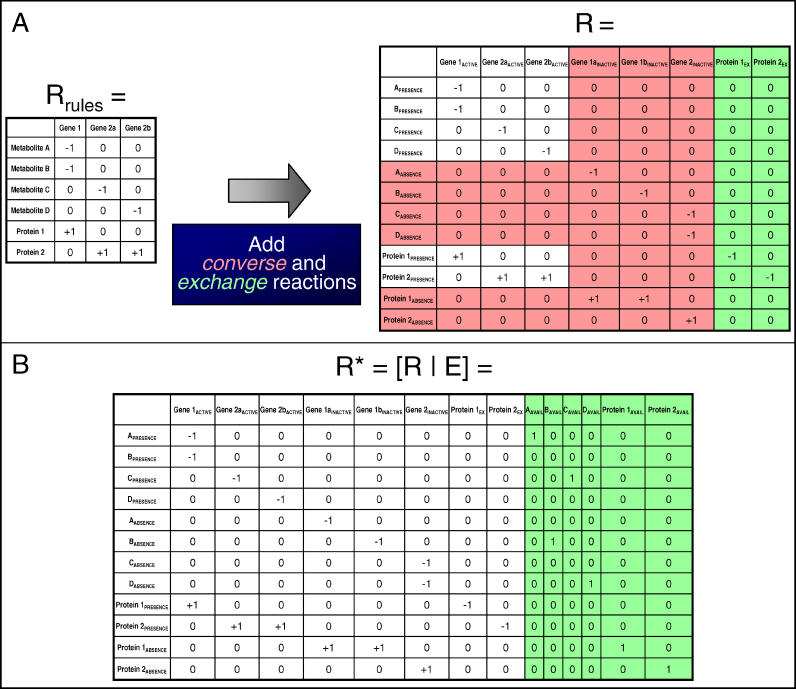
The Matrix as a Representation of a TRS(A) Depicts the TRN matrix shown in Figure 1 (Rrules). This matrix is expanded to yield the matrix R, which describes the complete TRS. The R matrix includes the converse of the regulatory rules, i.e., the regulatory reactions that lead to the inhibition of gene transcription (rows and columns shaded in pink). For example, the inhibition of Gene 1 requires either Metabolite A or Metabolite B to be absent. The R matrix also includes exchange reactions that balance the production of proteins and enforce the fact that the protein products are outputs of the TRN (columns shaded in green), thus representing a TRS.(B) The TRS R matrix is combined with the environment matrix (E), which consists of a set of columns that represent a particular environment of signaling stimuli (columns shaded in green), to yield the matrix R*. The presence or absence of a given signaling stimulus is denoted by a 1 or a 0 in the corresponding row in E. Initially, all the proteins are absent, and the availabilities of these are updated as the matrix is analyzed. Ultimately, these columns in E indicate the activation or inhibition of gene transcription for the environment.